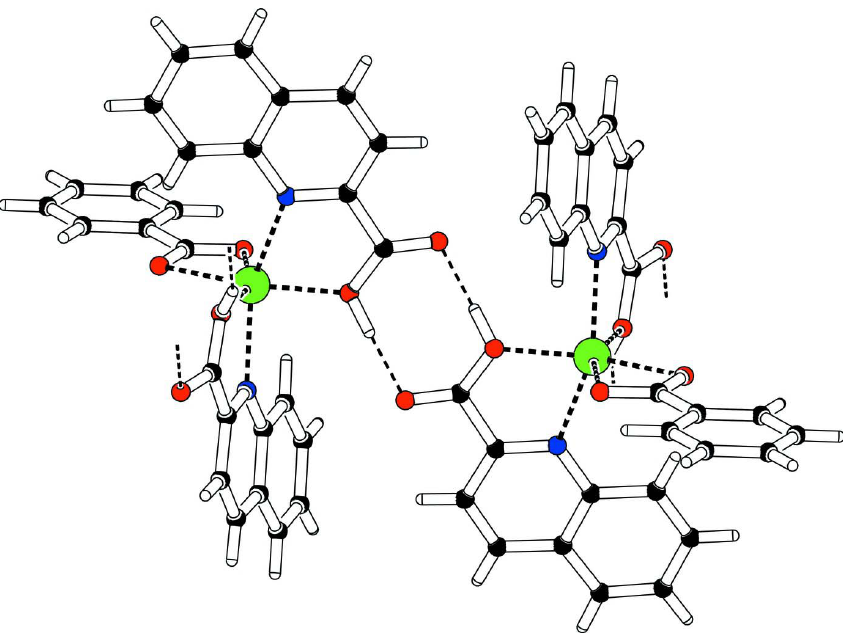
Figure 2 Two of the complexes joined by a hydrogen bond (depicted as a dashed line) between the carboxylic/carboxylate groups of the quinoline